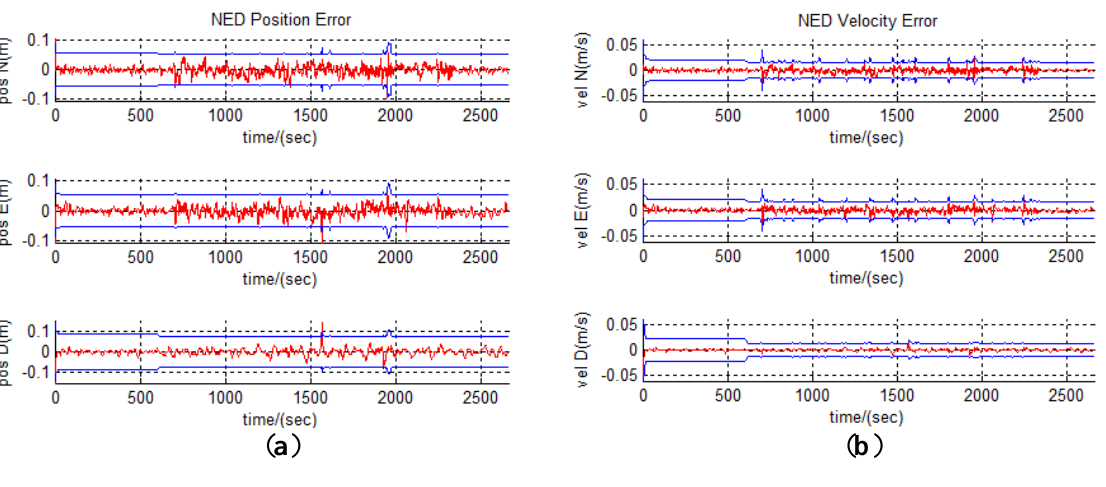
Figure 11. The estimated error states with IMU800CA (3-sigma envelope accuracy in blue). ( a ) Position Errors. ( b ) Velocity Errors. ( c ) Attitude